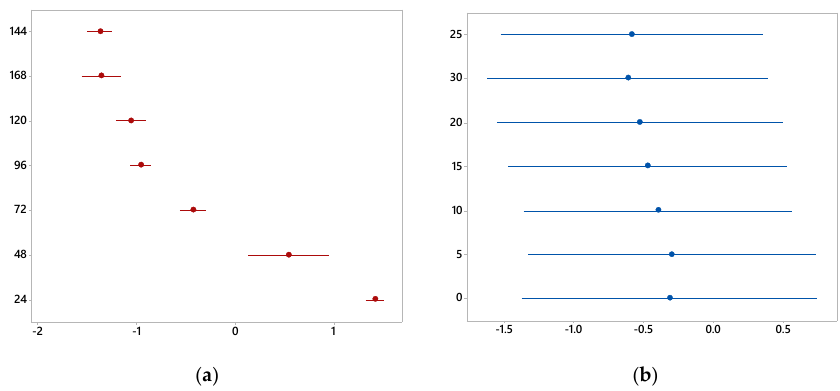
Figure 7. Comparison plots of means for the potential of the system in function of different levels of curing time ( a ) and NaCl concentration ( b ).